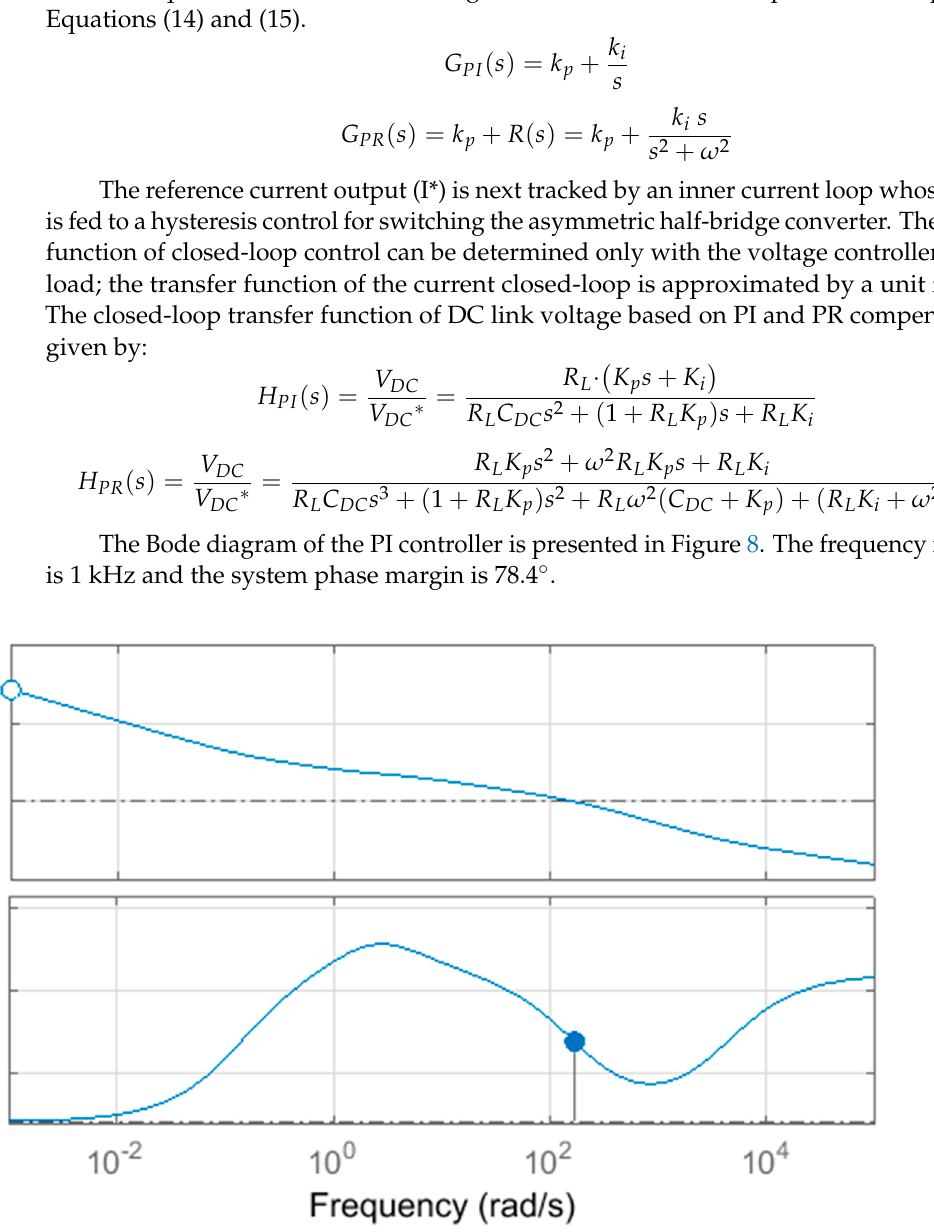
Figure 7. Voltage controller: ( a ) PI control; ( b ) PR control. The equations of PI and PR voltage control used for the comparison are depicted in Equations (14) and (15).